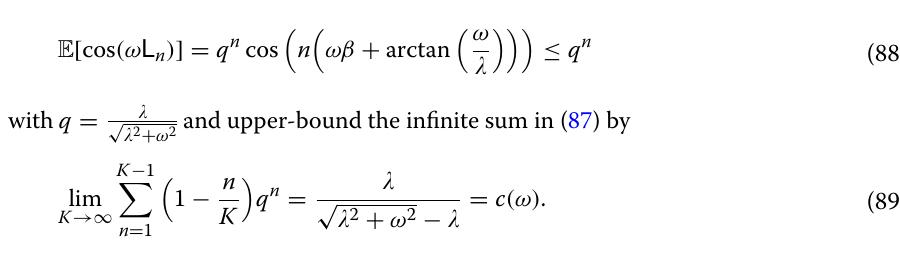
ing instances and L n sum of exponentially distributed random variables L n follows a Gamma-distribution, cf.